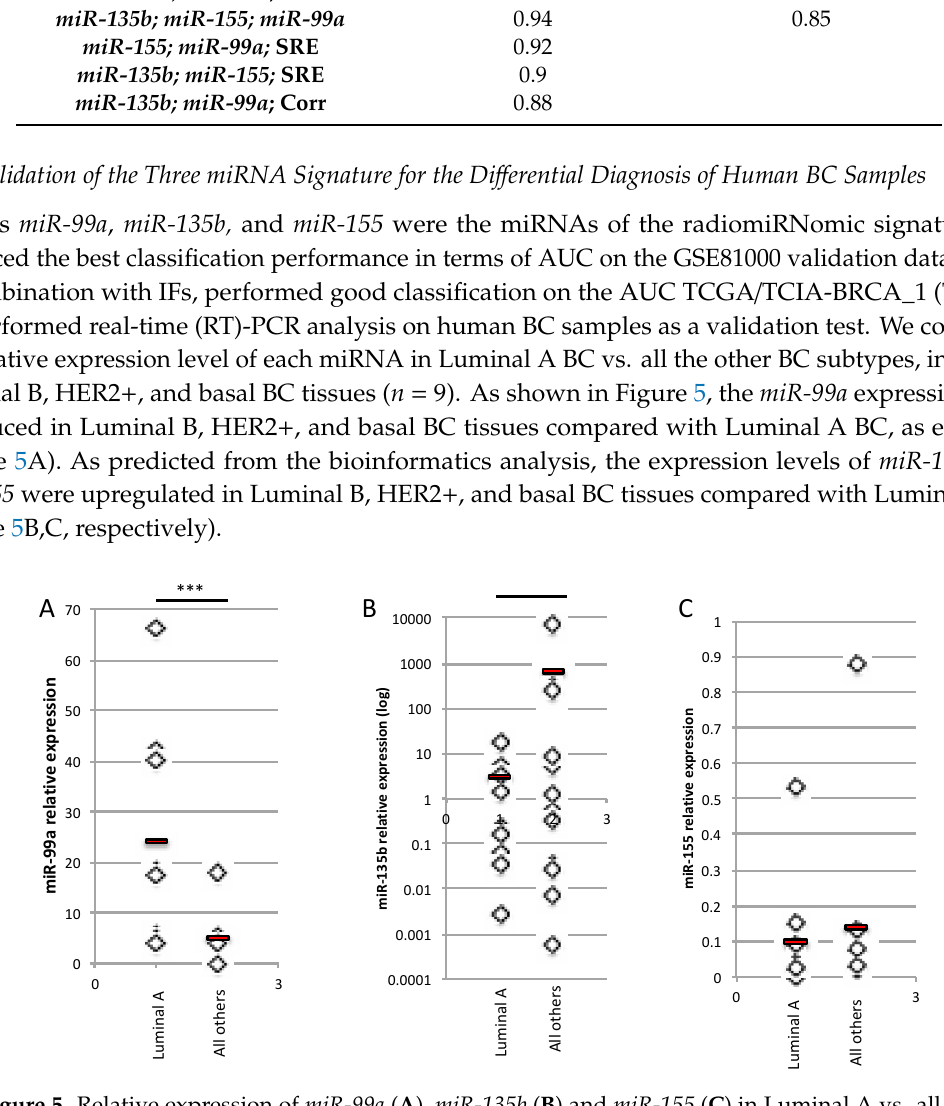
Figure 5. Relative expression of miR-99a ( A ), miR-135b ( B ) and miR-155 ( C ) in Luminal A vs. all the other BC subtypes (Luminal B, Basal, HER2 + ) ( n = 9) (*** t -test, p -value < 0.001).